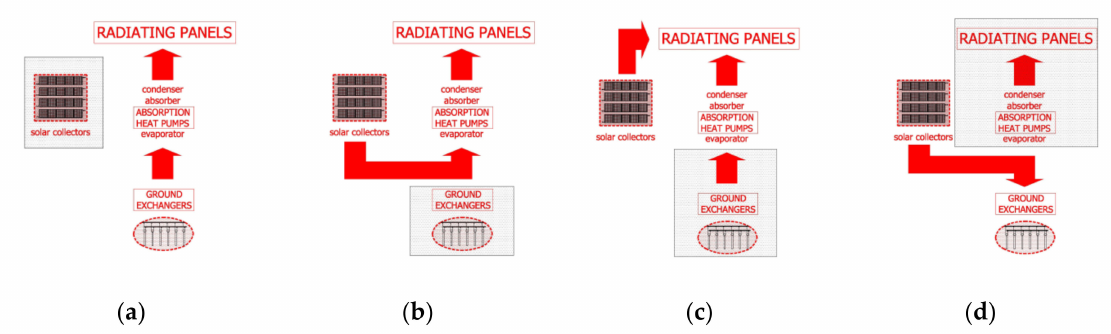
Figure 4. The space heating plant operating: ( a ) with solar collectors off; ( b ) with solar collectors on and low insolation; ( c ) with solar collectors and high insolation; ( d ) in summer